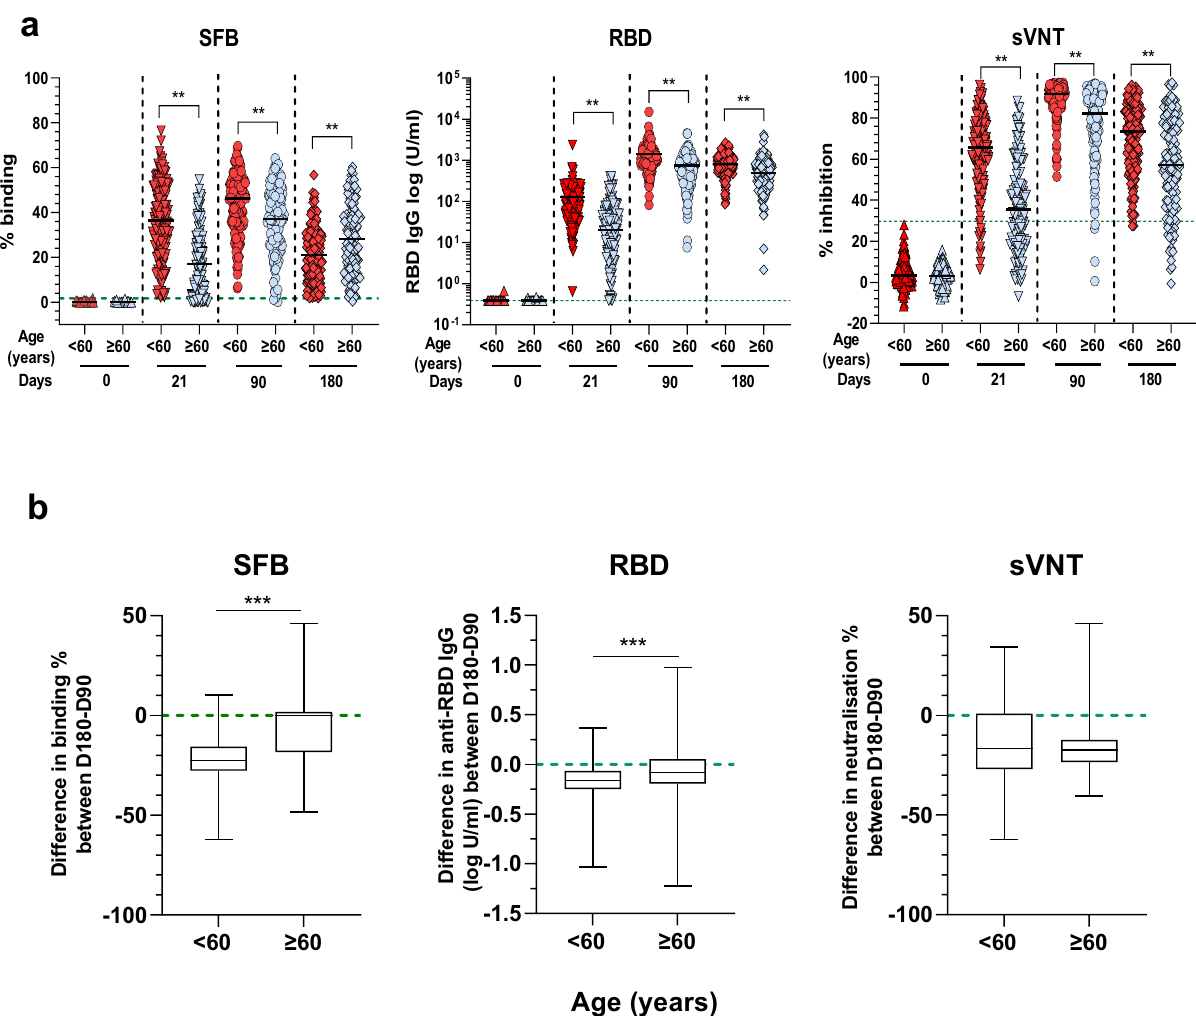
Fig. 2 | Age strati fi cation of antibody responses. a Comparison between age groups: <60 ( n =178) and ≥ 60 ( n =134), at different time points (day 0, 21, 90 and 180) using SFB (left panel); RBD Roche S assay (middle panel); and sVNT assay (right panel).The median value of each age groupis representedby the blackline. Thegreendottedlinesrepresentthemaximumrangeofthesamplesforthewhole cohortbaseline as de fi ned inFig.1. * p <0.01, two-sidedMann – Whitneytest. b Box